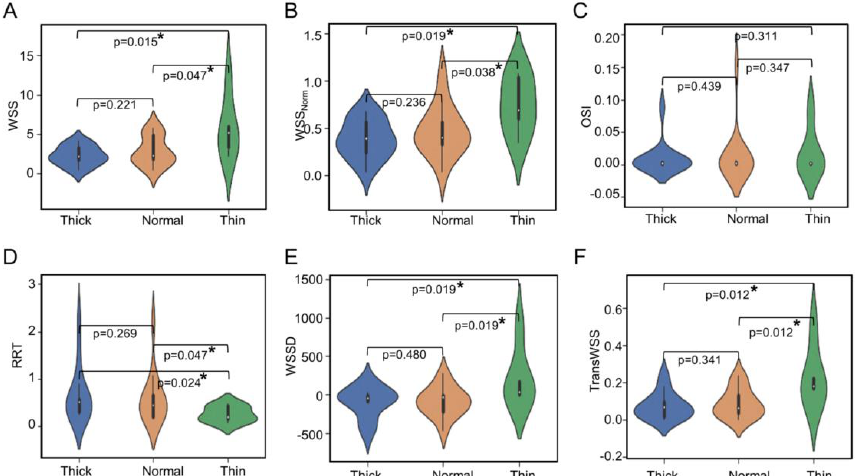
Figure 3. Pairwise univariate analysis of hemodynamic variables between different wall types across all IA sacs: The violin plots of median values of WSS ( A ), WSSNorm ( B ), OSI ( C ), RRT ( D ), WSSD ( E ), and TransWSS ( F ) across all IA sacs. All the significant differences ( p < 0.05) are marked with an asterisk (*). Abbreviations: WSS = wall shear stress, WSSNorm = normalized wall shear stress, OSI = oscillatory shear index, RRT = relative residence time, WSSD = wall shear stress divergence, TransWSS = transverse wall shear stress. We also performed these statistical analyses at a local level, i.e., on a node-to-node basis. Here, we analyzed many data points; ~127,000 points from the thick regions, ~25,000 from the thin regions, and ~93,000 from the normal regions. As shown in Supplemental Table S 1, multiclass and pairwise univariate analyses showed significant differences in all hemodynamic parameters between the regions (all p < 0.05). However, as these results may be skewed by the large sample size, we further calculated Cohen’s D for the pairwise analysis (Supplemental Figure S3). Similar to the comparisons of medians, this analysis showed higher WSS, higher WSS Norm , and lower RRT in thin regions, with a sufficient ef- fect size (D > 0.40) compared to both thick and normal regions. TransWSS was also higher in thin regions with good effect size (D = 0.415), but only in comparison to normal regions. 3.2. Correlation between Hemodynamic Variables and Percentage Wall Type To investigate the relationship further between median IA sac hemodynamic values and the amount of IA wall comprised of either thin or thick wall types, we performed a Pearson correlation analysis on cases where a substantial proportion of the wall was visi- ble. As shown in Supplemental Figure S4, we found that the percentage area of thin re- gions had a significant ( p = 0.010) and very strong positive correlation (PCC = 0.959) with WSS. There was also a strong negative correlation (PCC = − 0.735) between the percentage area of thin regions and RRT, albeit the trend was not statistically significant, p = 0.157. On the other hand, the percentage area of thick regions had a significant ( p = 0.041) and strong negative correlation (PCC = − 0.728) with WSSD (see Supplemental Figure S5). All other correlations were not strong or significant by the Wald’s test. 4. Discussion Studying the relationship between blood flow forces and local aneurysm pathobiol- ogy can help us understand the complex process of IA natural history. In this study, we explored the local and global relationship between different IA wall types observed on intraoperative imaging and aneurysmal hemodynamics from 3D image-based CFD. We found that thin, red regions of the aneurysm sac were exposed to significantly higher WSS,